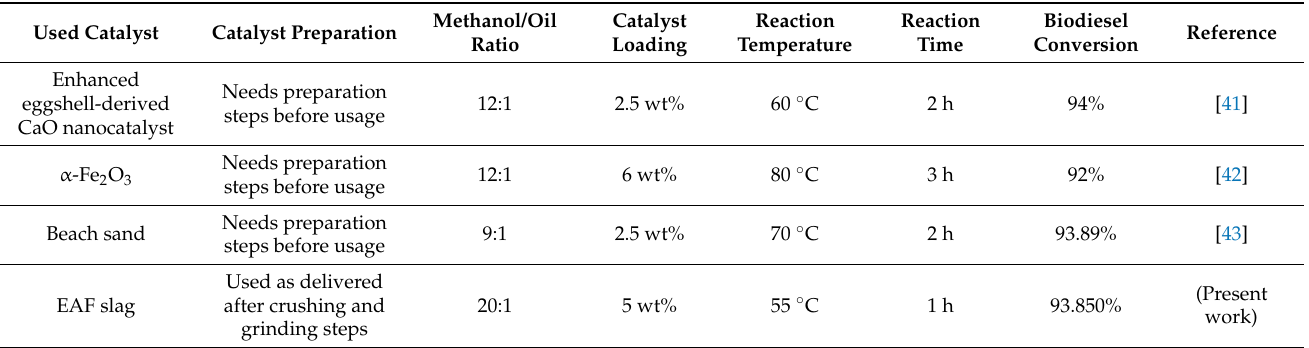
Table 9. Comparison between the results obtained in this paper and the results obtained from recent